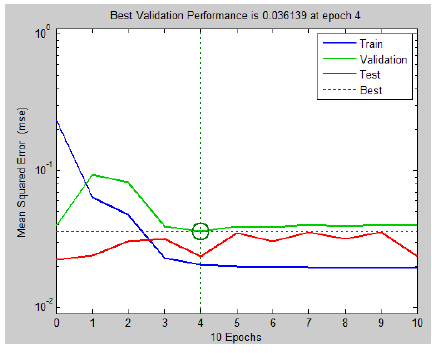
Figure 17. Result of validation for MLP neural networks created with structure 1:7:1. Source: By